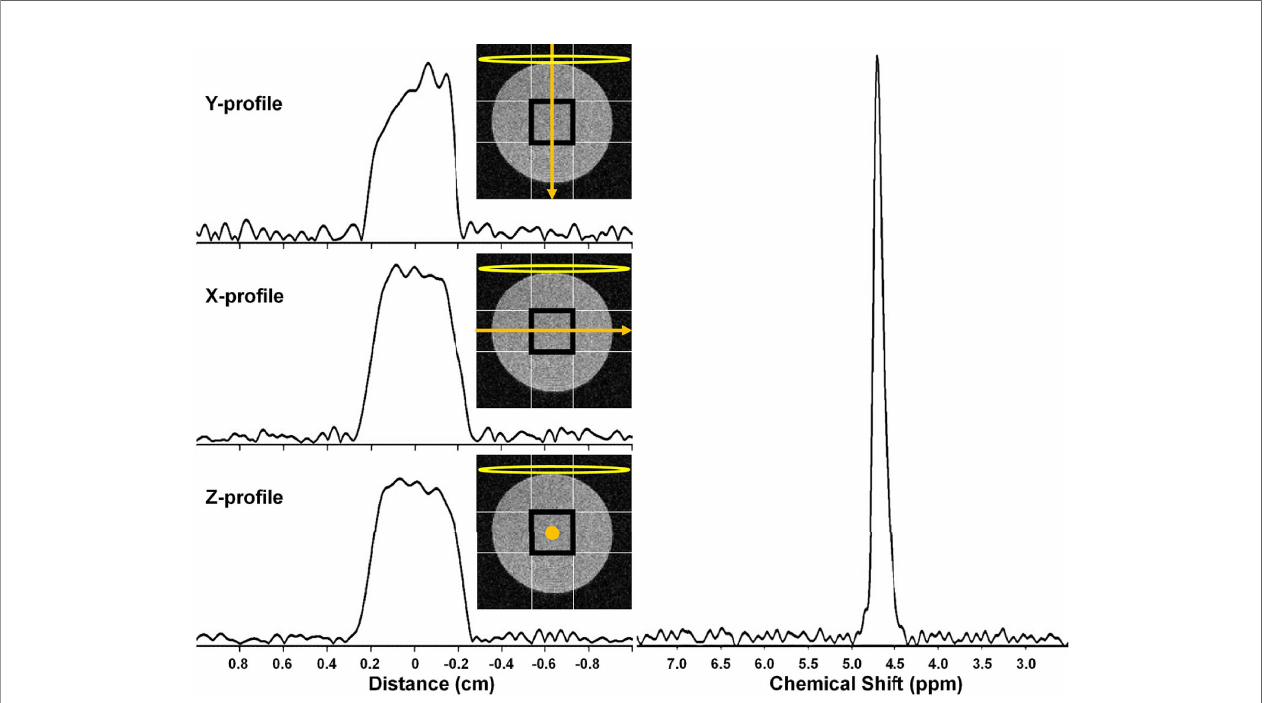
FIGURE 7 | (left) 2 H MRI pro fi les from a 4 × 4 × 4 mm 3 SPECIAL voxel in a 10% D 2 O cylindrical phantom in the (top) Y, (middle) X, and (bottom) Z. The nominal selected voxel is shown as a black square overlaid on a transverse slice (light gray) through the phantom, the pro fi le direction as an orange arrow, and the RF surface coil as a yellow oval. (right) 2 H MR spectrum resulting from selection of this 4 × 4 × 4 mm 3